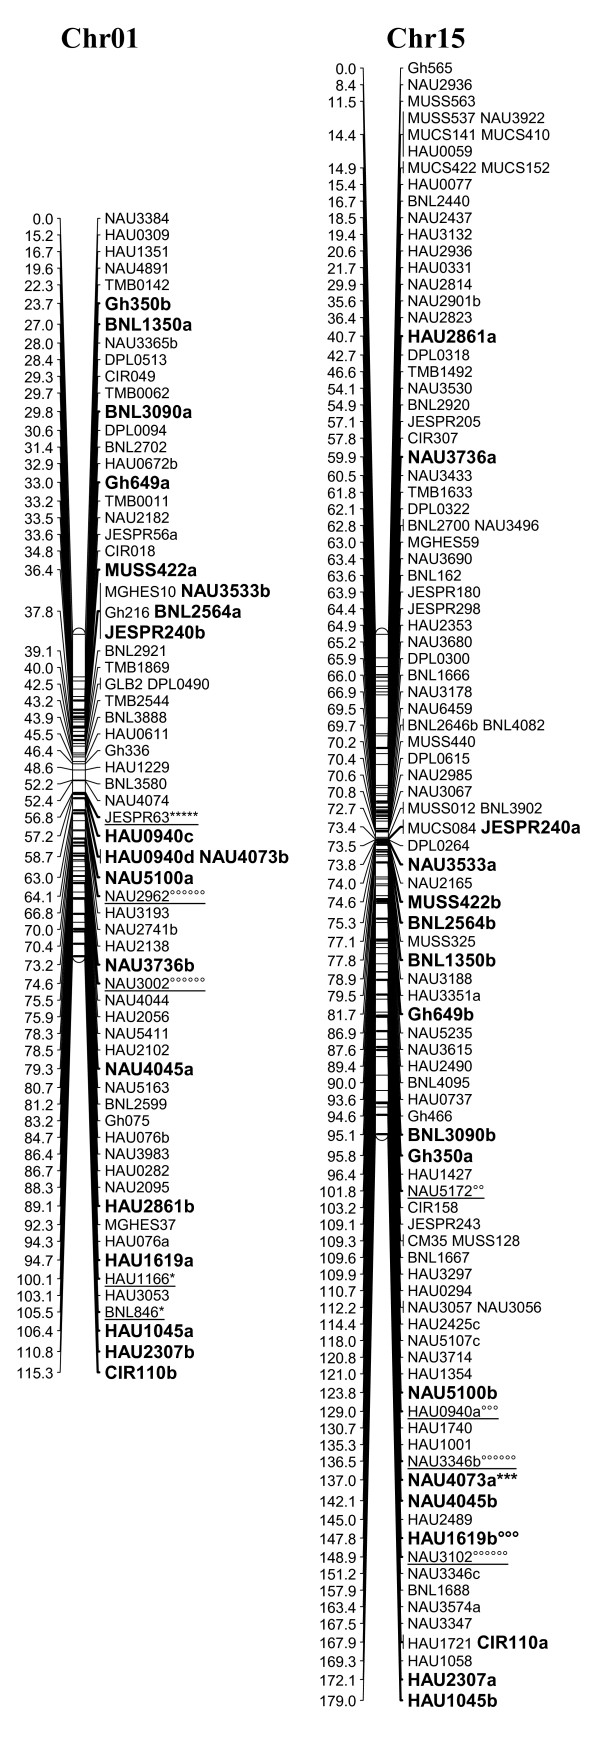
The genetic map of Chr01/Chr15 homoeologous chromosome. The interspecific genetic map was constructed using the BC1 population [(Emian22 × 3-79) × Emian22]. Duplicated loci are in bold. Map distances are given in centimorgans (cM). Markers showing segregation distortion are underlined and indicated by asterisks (*P < 0.05; ** P < 0.01; *** P < 0.005; **** P < 0.001; ***** P < 0.0005; ****** P < 0.0001 for markers skewed toward the 'Emian22' allele or degree symbols (°P < 0.05; °°P < 0.01; °°°P < 0.005; °°°°P < 0.001; °°°°°P < 0.0005; °°°°°°P < 0.0001 for markers skewed toward the heterozygous allele). Segregation distortion regions (SDRs) are named as 'Chromosome + No. SDR', for example, SDR2.1 refers to the first SDR on Chr02.